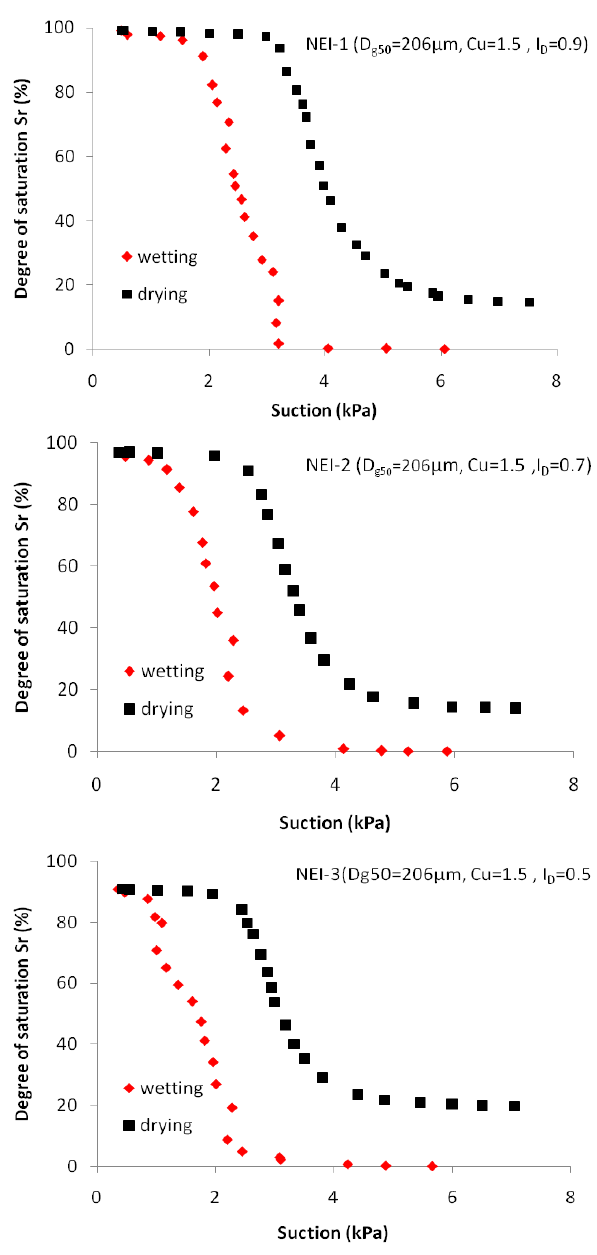
Figure 6: Experimental results used in this study (Feia et al. [25]).